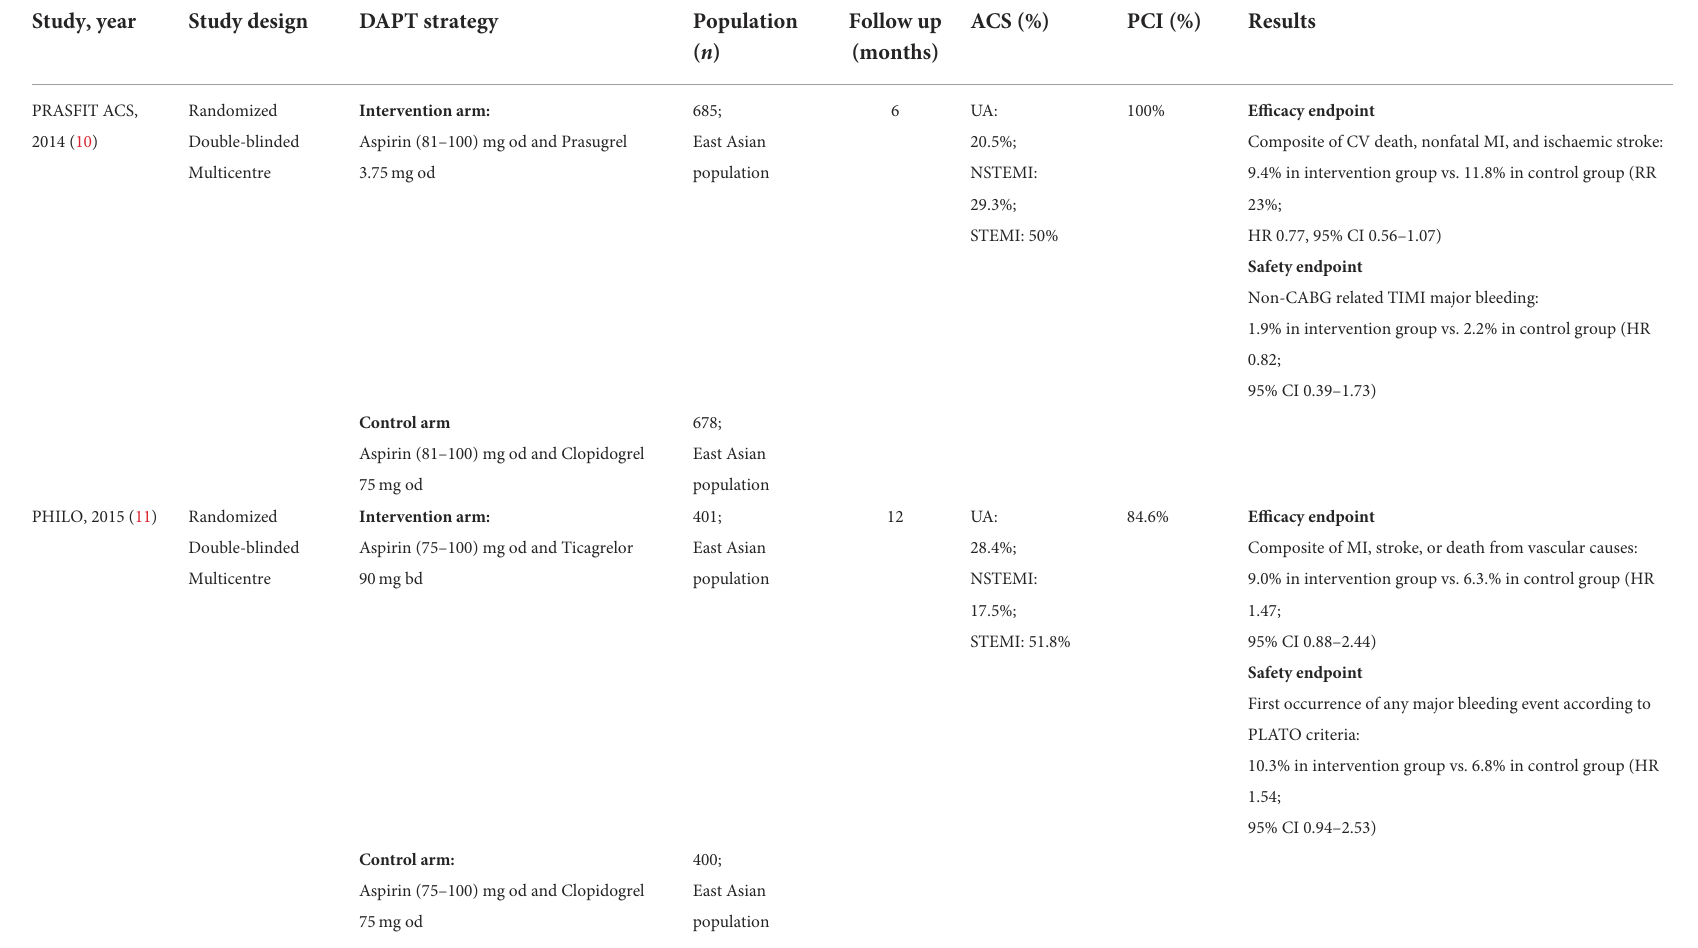
TABLE 1 Reduced intensity or de-escalation of dual antiplatelet therapy intensity in ACS population undergoing